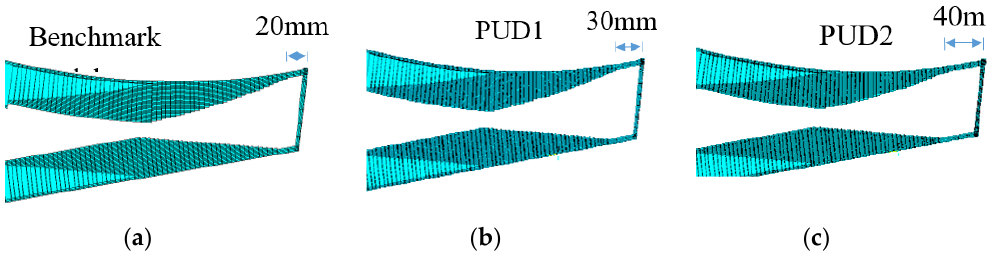
Figure 16. Differences between PUD and benchmark models: ( a ) Position of UD in the benchmark model was 20 mm; ( b ) Position of UD in the PUD1 model was 30 mm; ( c ) Position of UD in the PUD2 model was 40 mm.